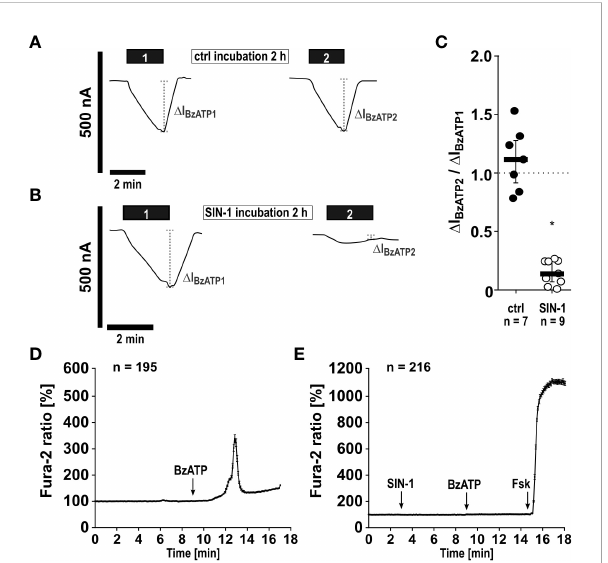
FIGURE 6 The NO and peroxynitrite donor SIN-1 inhibits BzATP-induced ion channel functions of heterologously expressed human P2X7 receptors (hP2X7R). (A – C) Two-electrode voltage-clamp